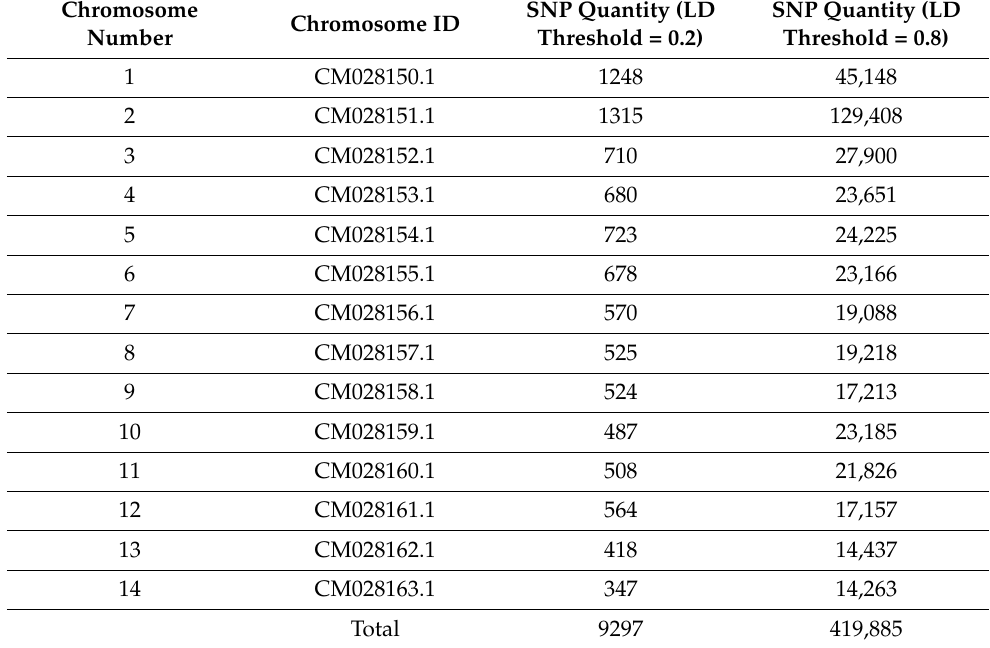
Table 3. SNP quantity by chromosome based on filtering with linkage disequilibrium (LD) thresholds set to 0.2 and